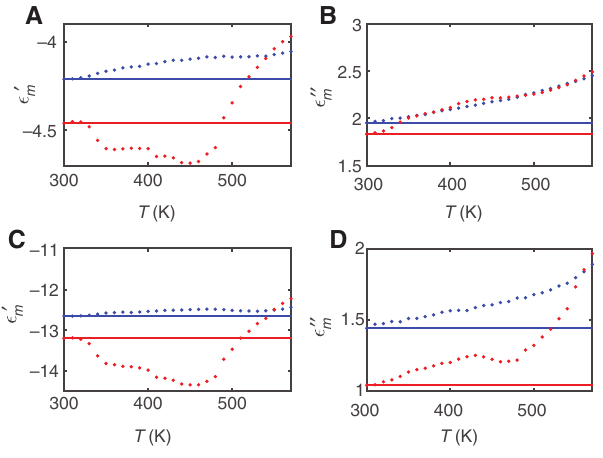
Figure 1: Au ellipsometry data. (A) Real and (B) imaginary parts of the (relative) permittivity extracted from the ellipsometry measurements of an annealed (blue) and unan- nealed (red) Au film at λ = 533 nm for 300–570 K. (C and D) Same data for λ = 671